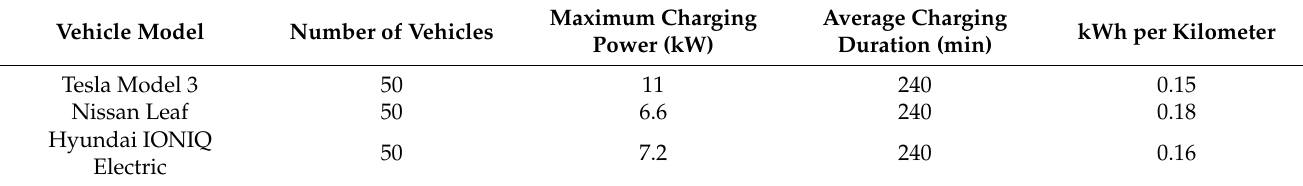
Table 5. Energy consumption of EV based on the generated load profile.